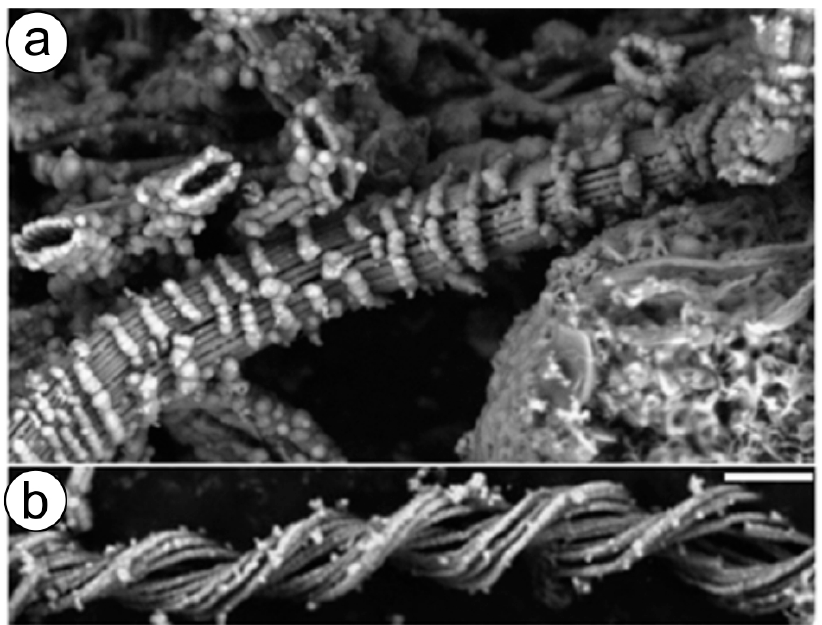
Figure 4. ( a, b ) SEM micrographs of mat and crust material from the Ula Nui hydrothermal vent area show diverse Fe-containing structures. The banding patterns of unusual nanoparticle morphologies observed are thought to be of biogenic origin but have not been reported elsewhere. Scale bar 1 µm. (Reprinted by permission from Macmillan Publishers Ltd: The ISME Journal [194], copyright 2011).